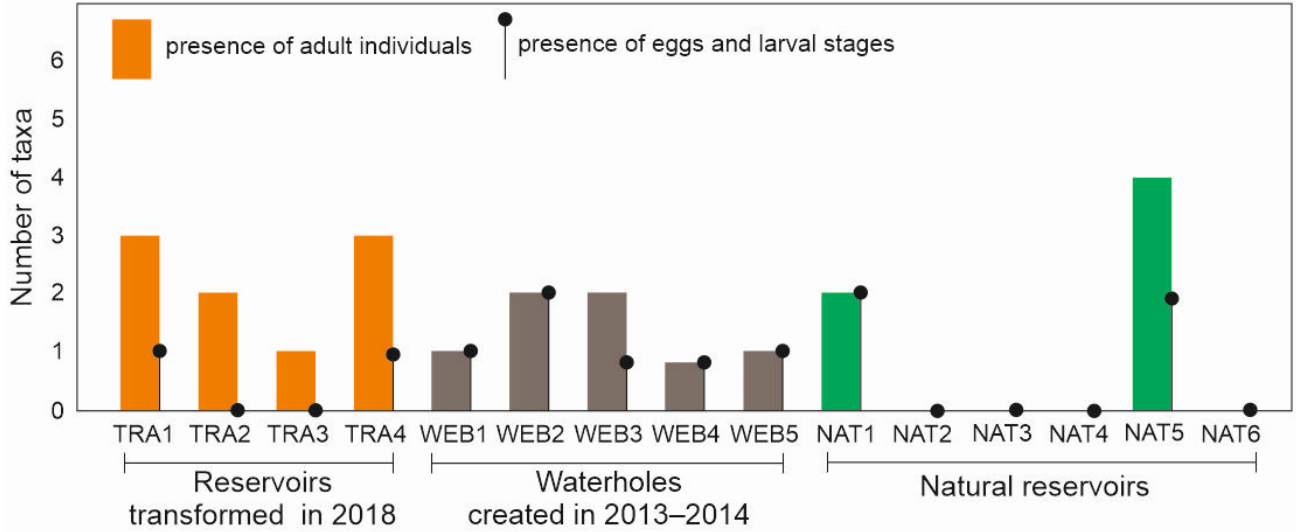
Figure 6. Number of amphibian taxa found in the examined water reservoirs in 2020.